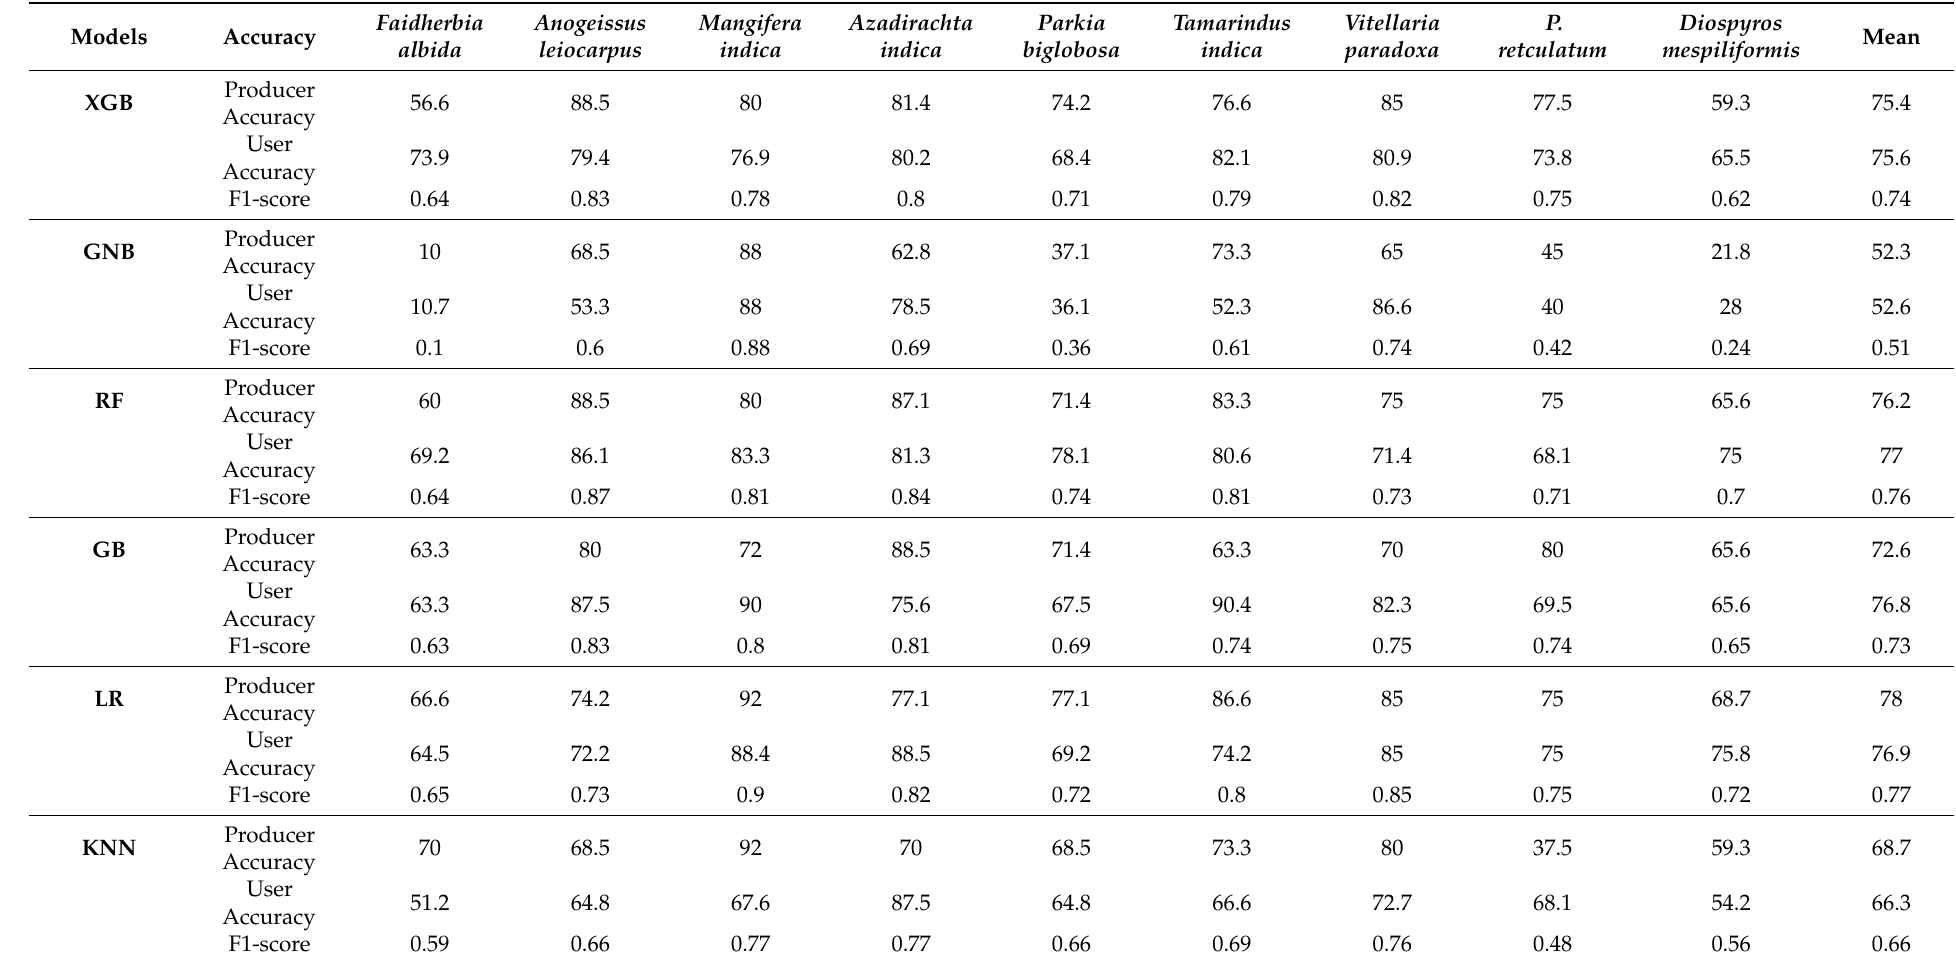
Table 7. Species-wise user, producer accuracy, and F1-score by different learning methods.